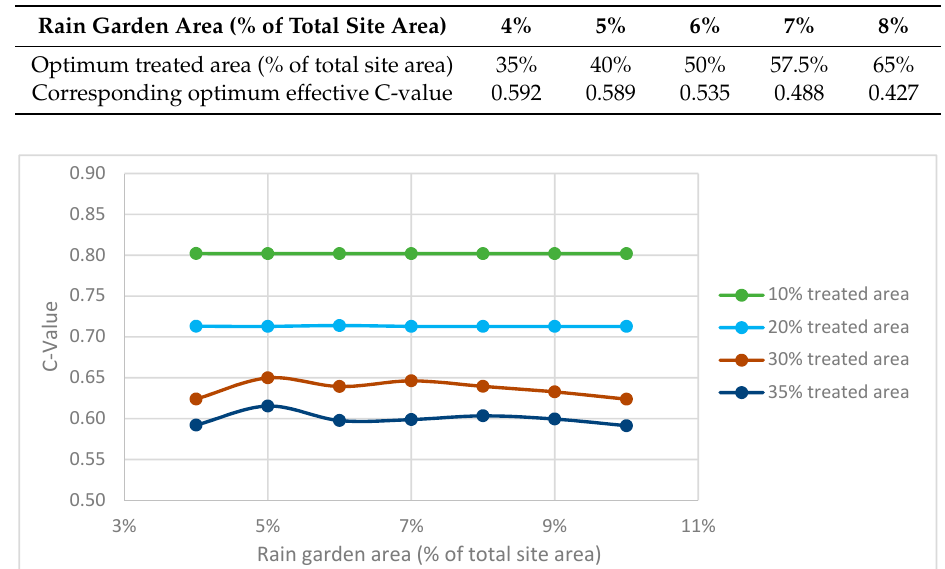
Figure A5. Residential precinct plot of effective runoff coefficient versus rain garden size for treated catchment areas of 10–35%.